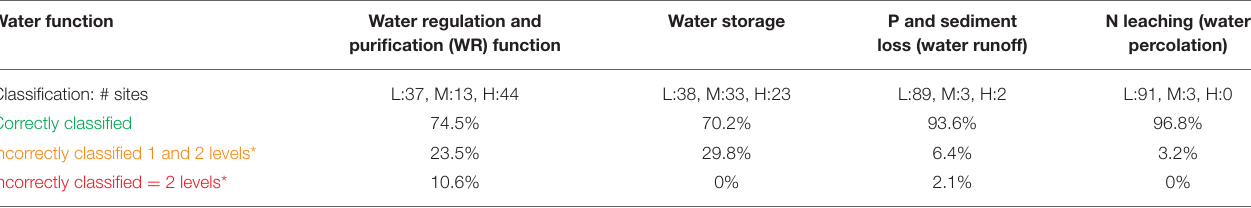
TABLE 4 | No of sites classified as either low (L), medium (M), or high (H) and model performance compared to empirically derived water regulation and purification (WR) function assessments across the 94 European soil quality monitoring sites. Water function Water regulation and Water purification (WR) function